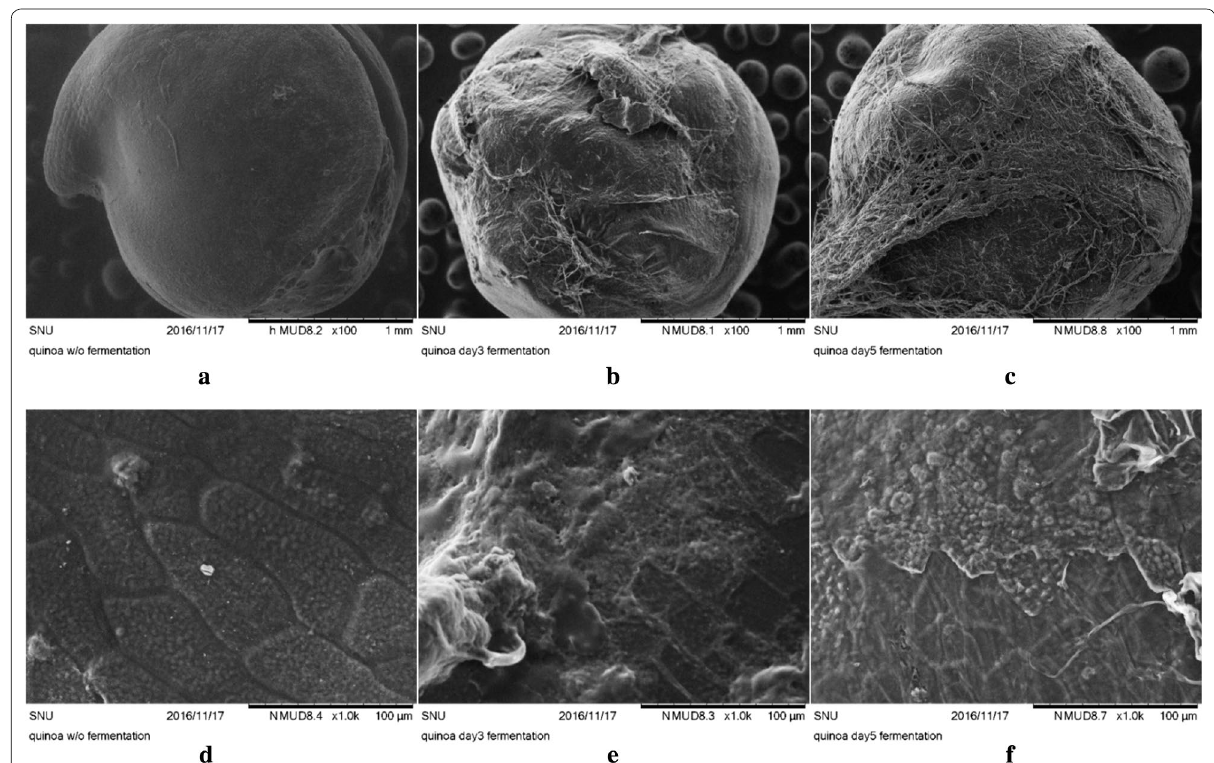
Fig. 1 Scanning electron microscope of fermented quinoa. a NF, removed 5F, 1000. ( NF Non-fermented, 3F; 3 days, 5F; 5 days of fermented quinoa extracts) ×